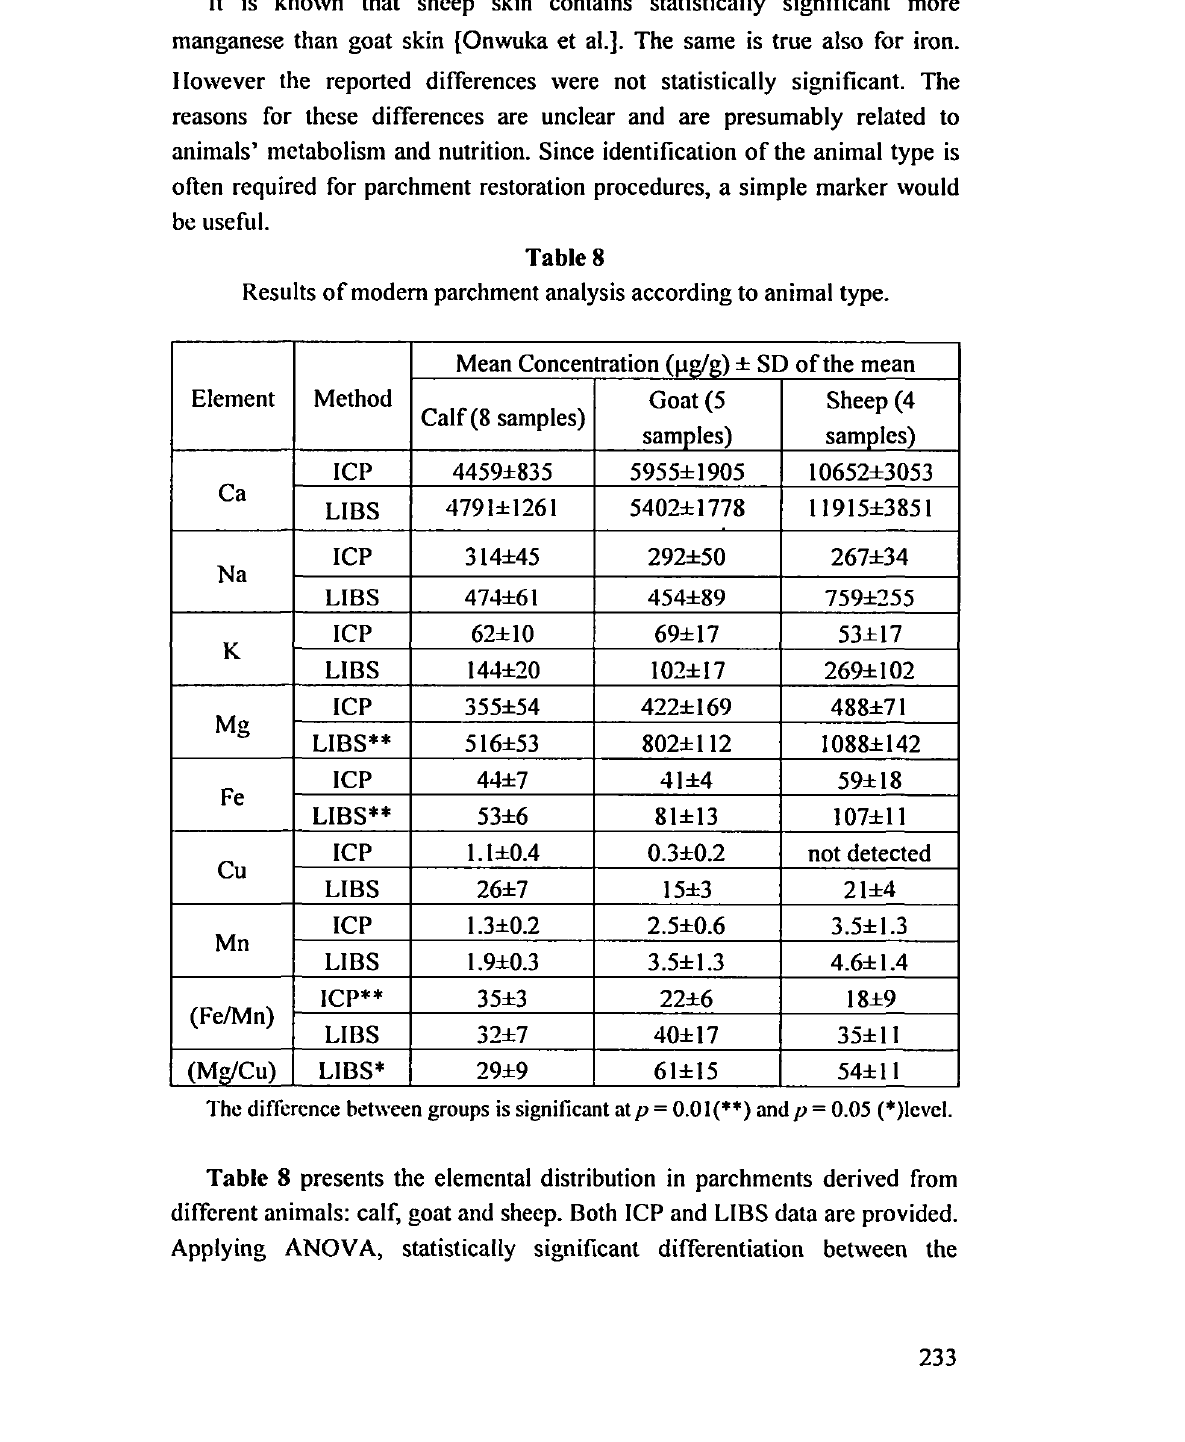
Results of modern parchment analysis according to animal